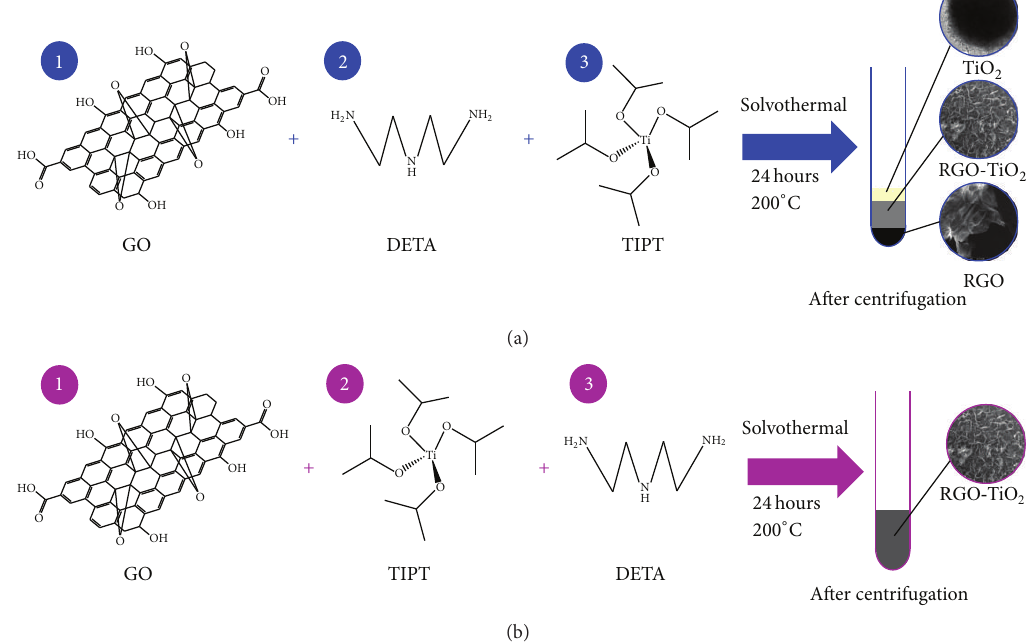
Figure 1: Schematic illustration of the preparation of RGO-TiO 2 composite in sequence, producing, after centrifugation, (a) three different layers (RGO, TiO 2 and RGO-TiO 2 ), and (b) a single homogeneous layer of the RGO-TiO 2 composite.